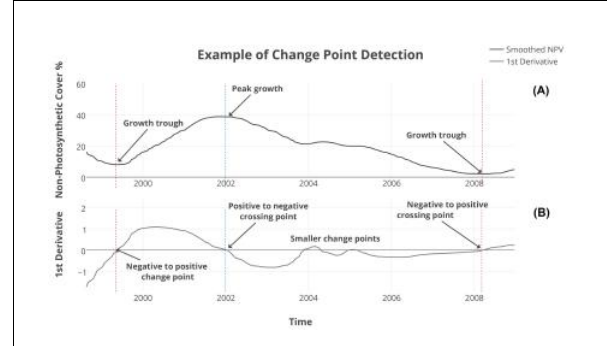
Figure 6. Example of minimum and maximum NPV change point detection. Plot (A) illustrates a time series of NPV cover, a smoothed spline fitted to the time series and the locations of the peak ( blue ) and ( red ) trough change points. Plot (B) is a first derivative time-series of the spline function in the top plot. The x crossing axis points illustrated in blue and red are used to determine the locations of the maximum and minimum change points in the top plot.